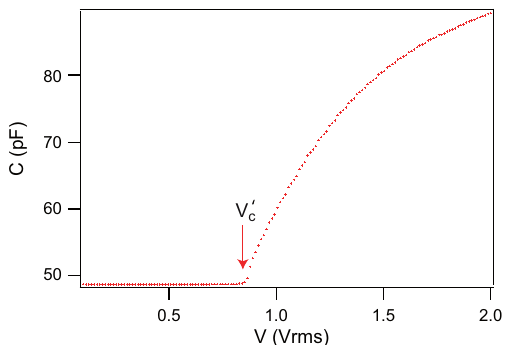
Figure 5. Capacitance curve measured in a planar sample of thickness d = 50 µ m at T = 38 ◦ C.